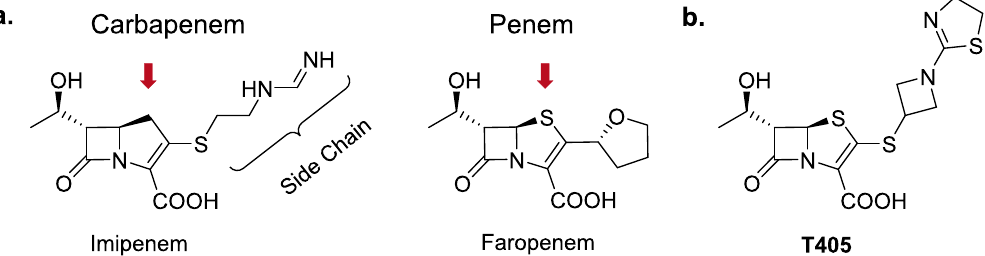
Fig. 1 Carbapenem and penem β -lactam antibiotics. a Structures of the carbapenem Imipenem and the penem Faropenem are shown with red arrows indicating the differences in the ring structures. b Structure of the new penem developed here,